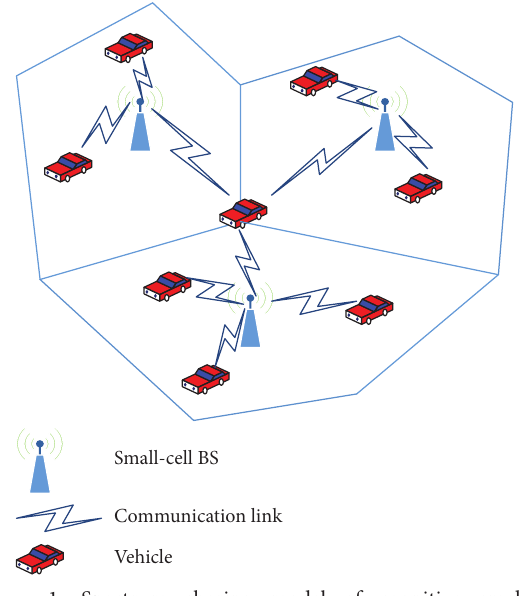
Figure 1: Spectrum sharing model of cognitive small-cell